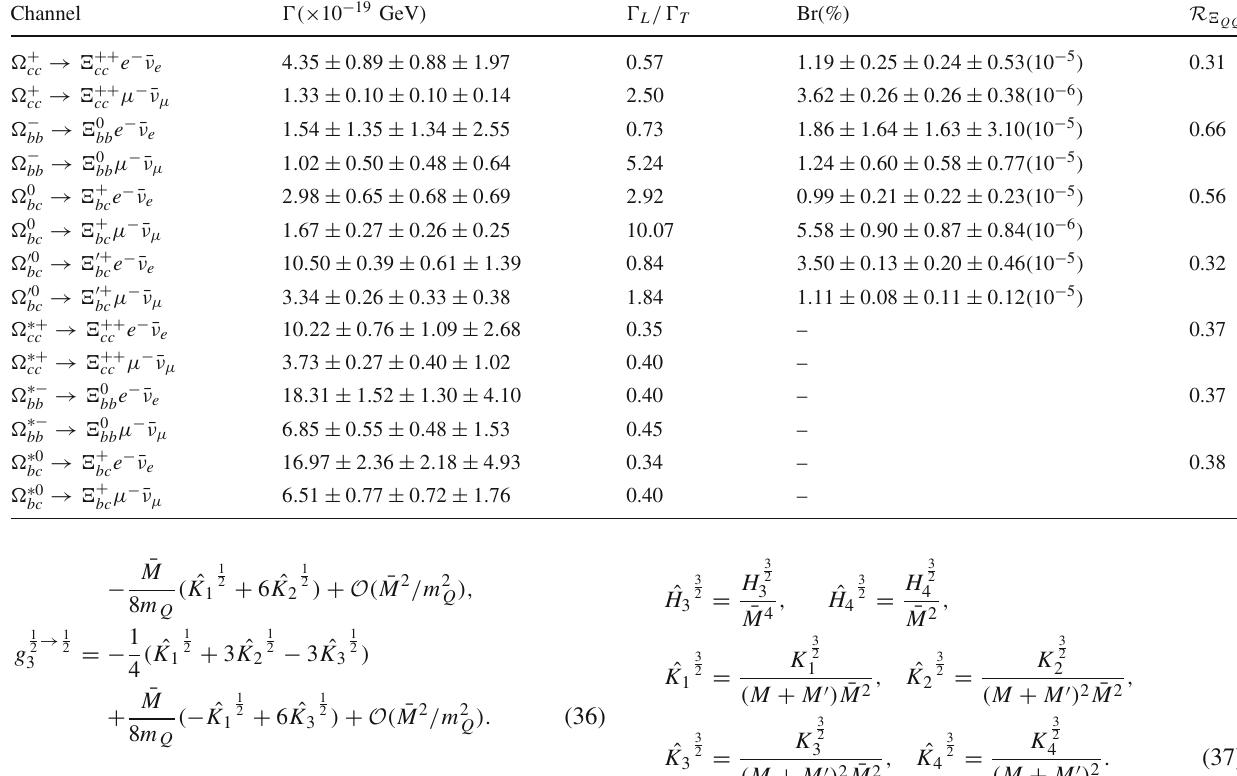
Table 6 Numerical results of decay widths and branching fractions in doubly heavy baryon semileptonic decays using constant form factors F ( q 2 ) = F ( 0 )